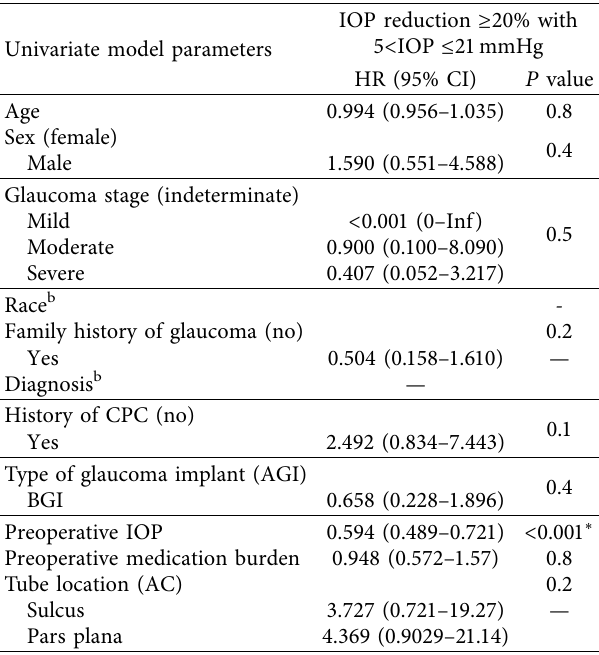
Figure 2: Kaplan-Meier survival curves of glaucoma drainage device placement in the anterior chamber (red), sulcus (blue), and pars plana (green). Success criteria were defined as the following: postoperative intraocular pressure (IOP) reduction Table 7: Hazard ratios from univariate Cox proportional hazard models using demographic and preoperative data a .